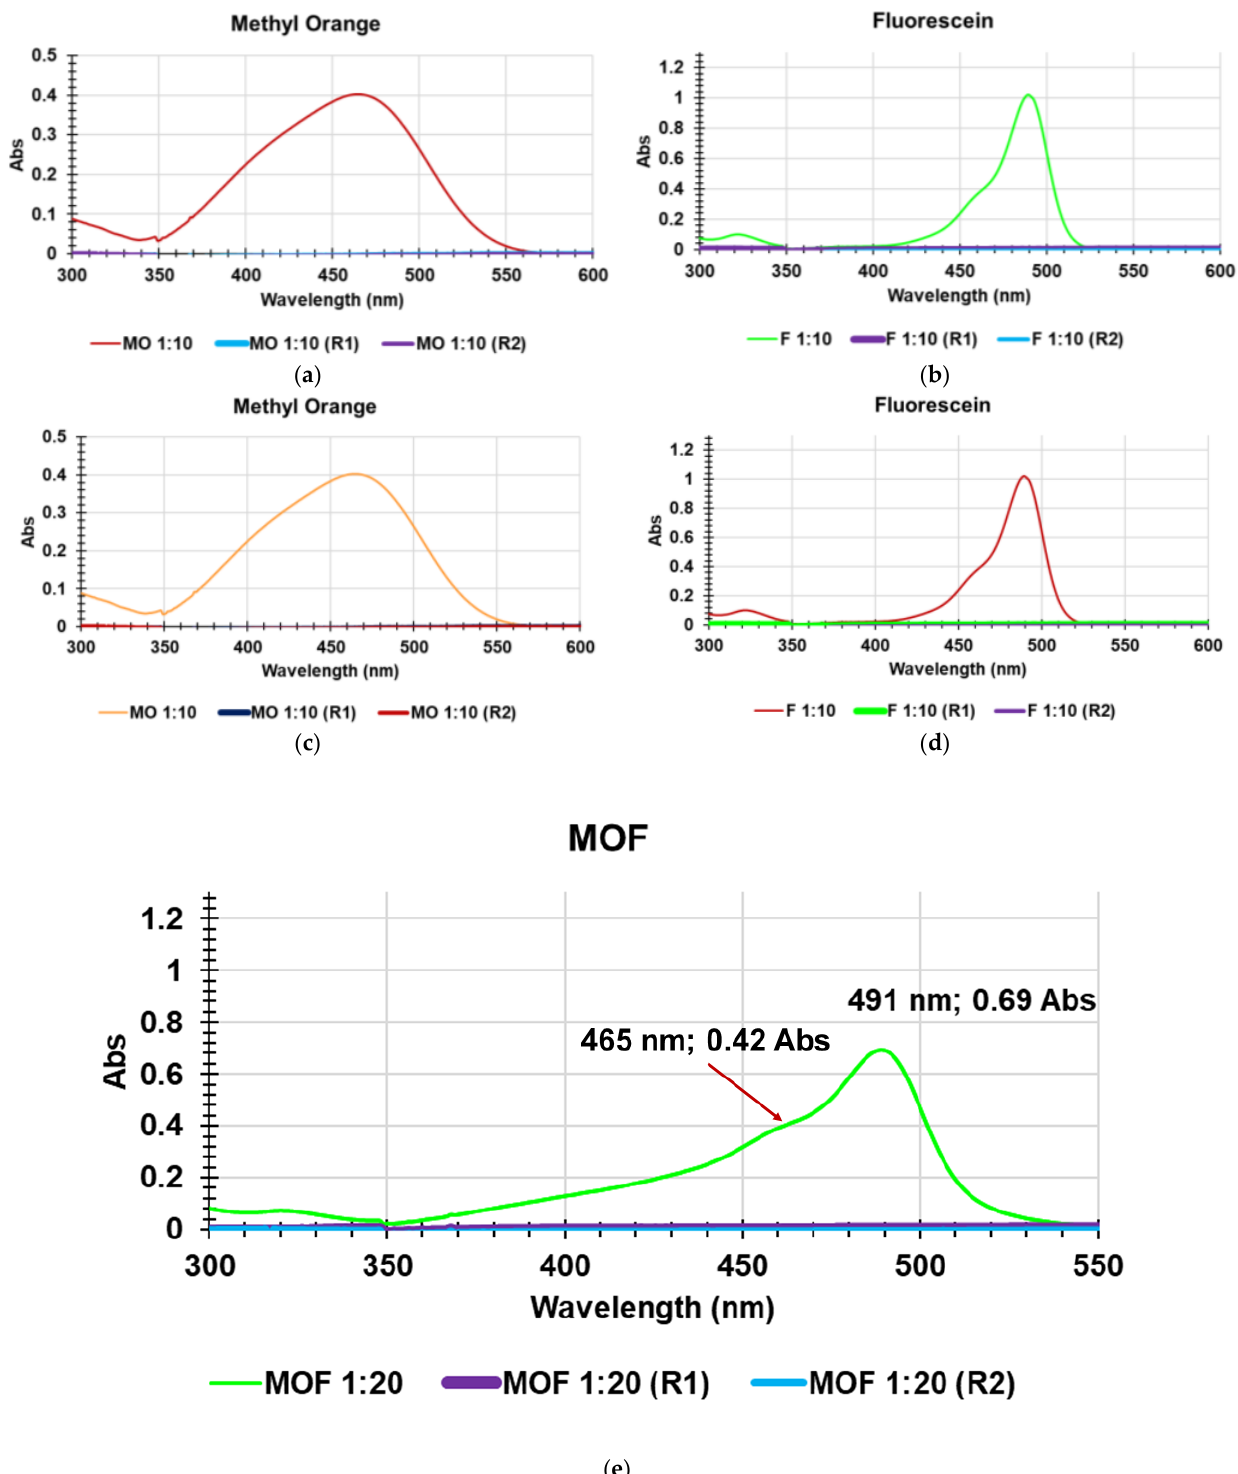
Figure 14. UV-Vis spectra of MO ( a , c ), F ( b , d ) and MOF ( e ) solutions before filtration (red or green lines) and after filtration through R1HG (purple lines) and R2HG (light blue lines). Figure 14c,d refer to filtration experiments of MO solution followed by F solution carried out without refreshing the hydrogel. Columns: 8 mL hydrogels; pH = 7.5; r.t. Filtrations were first by gravity and were finished by applying compressed air to the top of columns up to completely empty the columns.